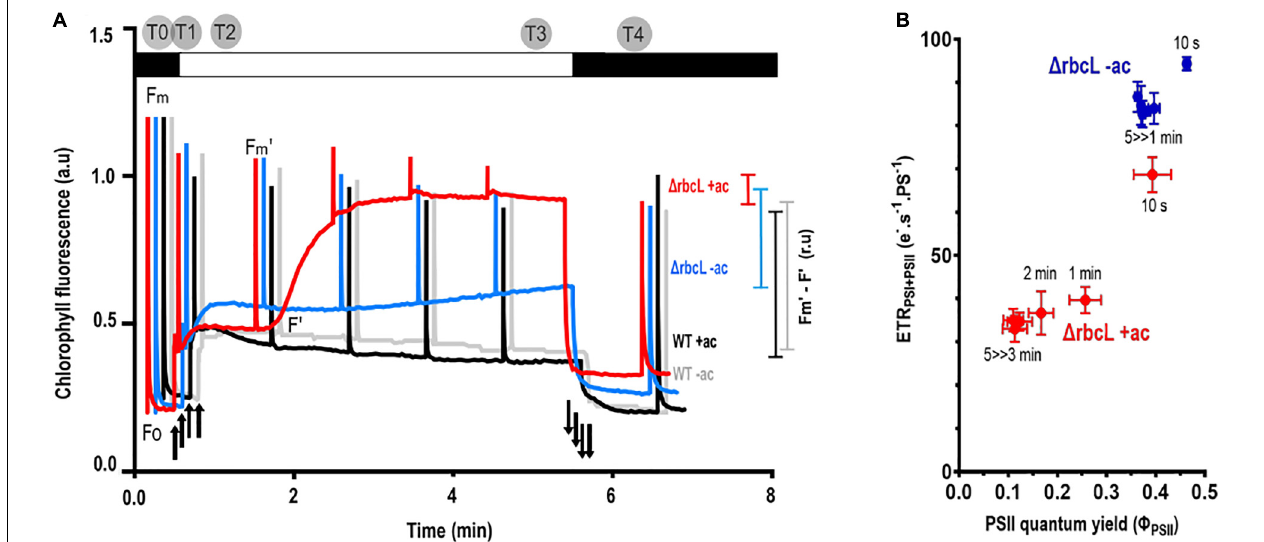
FIGURE 2 | Acetate has significant effects on photosynthetic activity in (cid:49) rbcL . Photosynthetic yield as a proxy for photosynthetic electron transport. (A) Typical chlorophyll fluorescence kinetics for wild-type cells cultured with acetate (+ ac) in black, without acetate (–ac) in gray, and comparison with (cid:49) rbcL chlorophyll fluorescence kinetics when grown with acetate (+ac, in red) or resuspended in medium without acetate (–ac, in blue). Cells were dark adapted and subjected to 300 µ mol photons m − 2 s − 1 actinic light over 5 min with saturating flashes to probe photosynthetic yield in the light shown as colored bars on the right of the figure (F m (cid:48) -F (cid:48) ). Light switched on and off is denoted respectively by up and down arrows. Time points for the metabolite sampling are represented on the upper part of the graph. (B) ETR PSI + PSII as a function of ϕ PSII over a 5 min illumination in (cid:49) rbcL in acetate-replete (dark, red symbols) or acetate-deplete (open, blue symbols) medium. The time in the light before taking a measurement is shown by the labels. ϕ PSII values were derived from the chlorophyll fluorescence kinetics as in Figure 2A . ETR PSI + PSII was measured as the decay rate of absorbance (cid:49) A 520 nm (electrochromic shift of carotenoids, ECS).